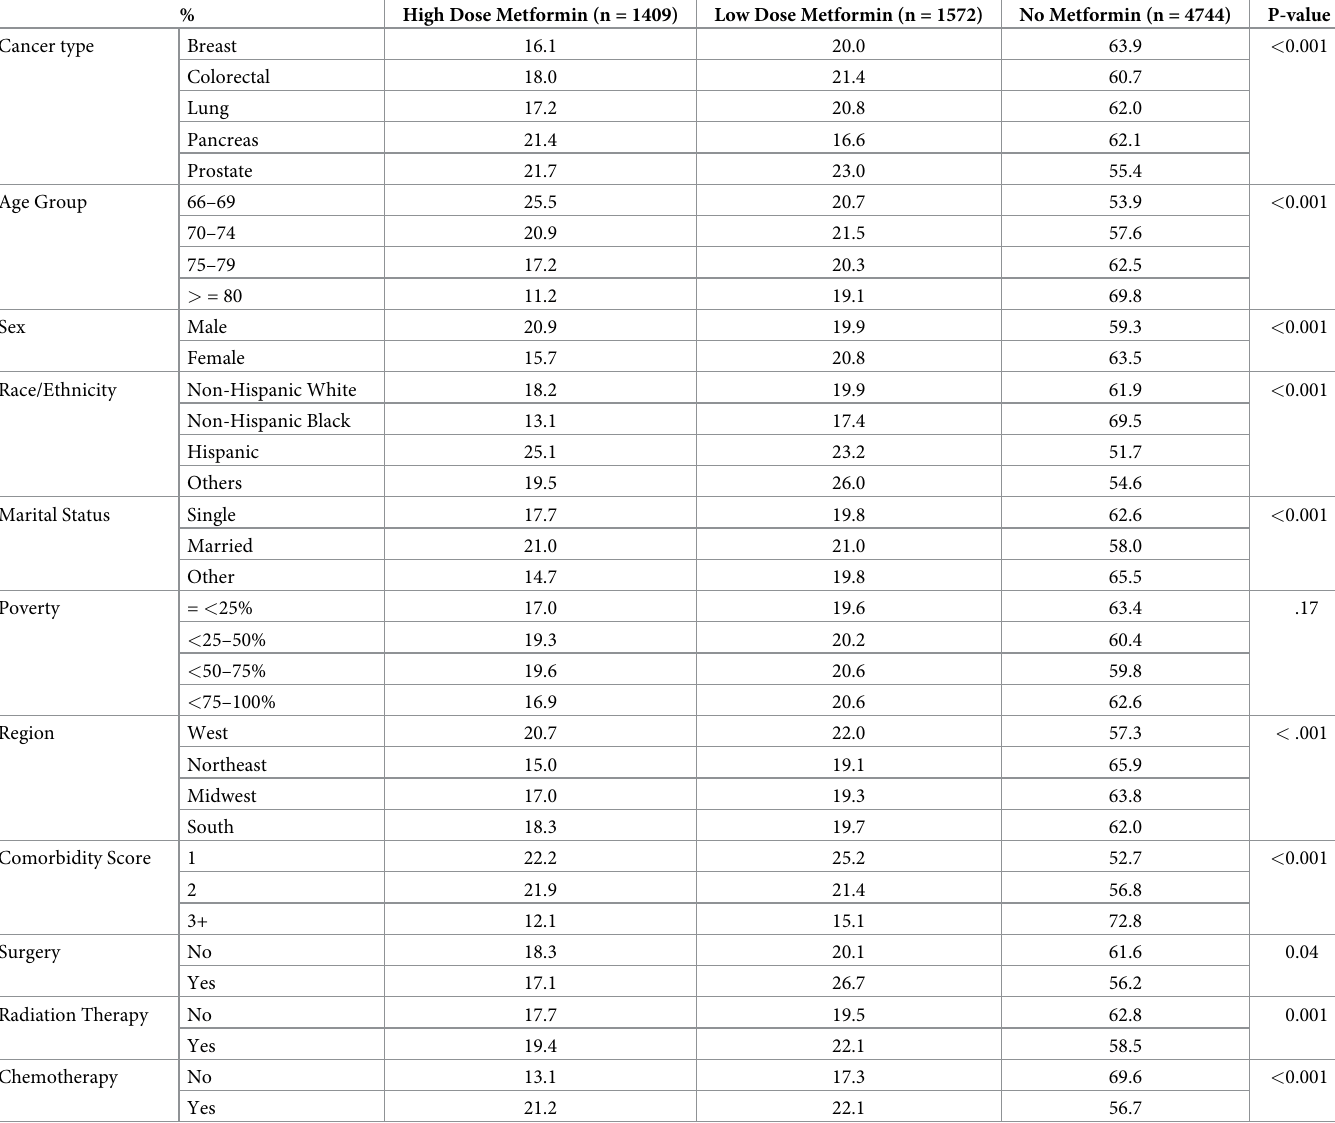
Table 1. Baseline characteristics of patients with cancer (e.g., lung, prostate, colorectal, pancreas and breast cancer) using Medicare claims data, 2007–2016 (n =